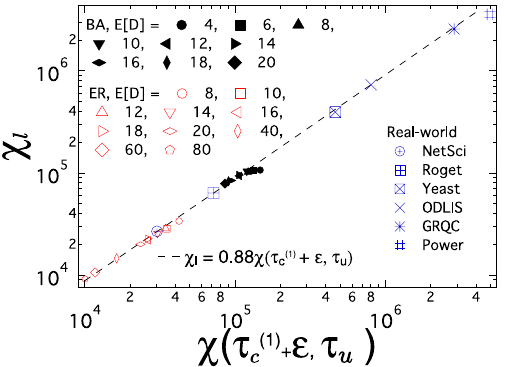
(1) in ER random graphs (with c u